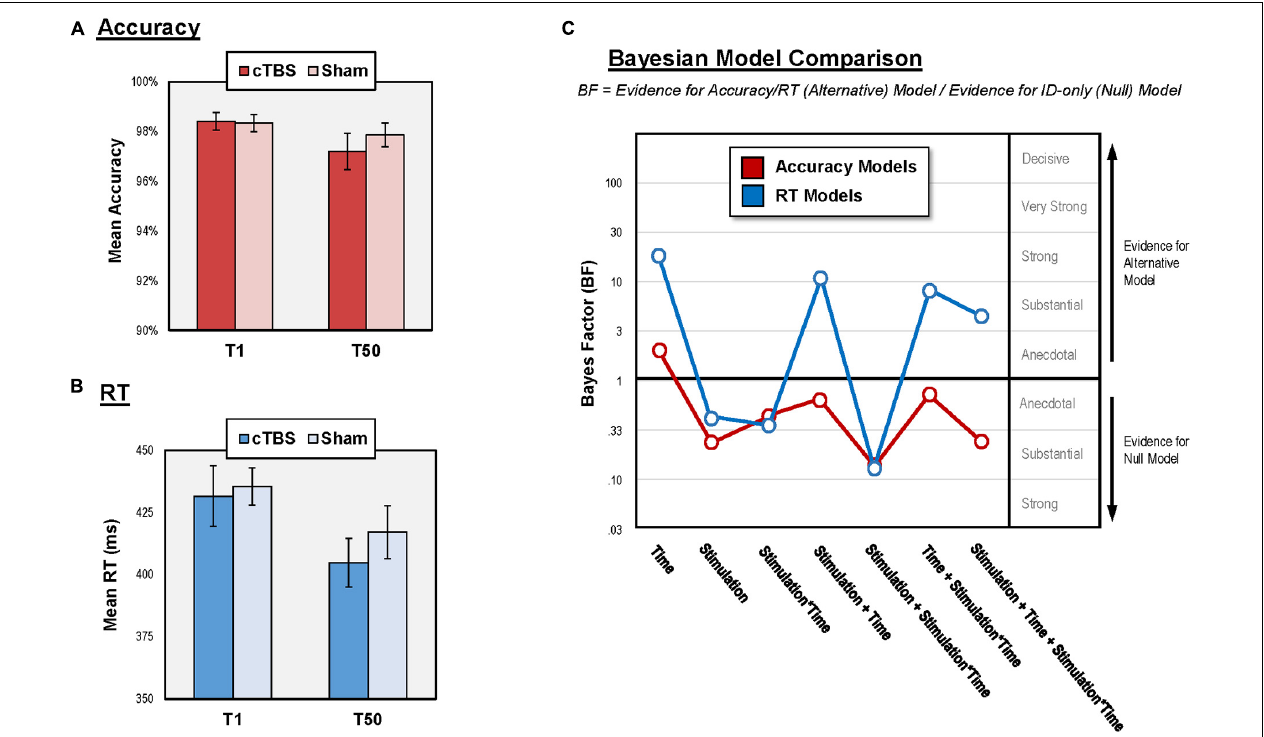
FIGURE 4 | Results of central vision performance analysis. (A) Mean accuracy for each condition and administration time; (B) Mean RT for each condition and administration time; (C) Bayesian model comparison results for all models relative to ID-only model. BF > 1 suggest change in vision performance while BF < 1 suggest no change. RT, reaction time; cTBS, continuous theta burst stimulation; V2, secondary visual cortex; ms, milliseconds; T1 and T50, 1- and 50-min